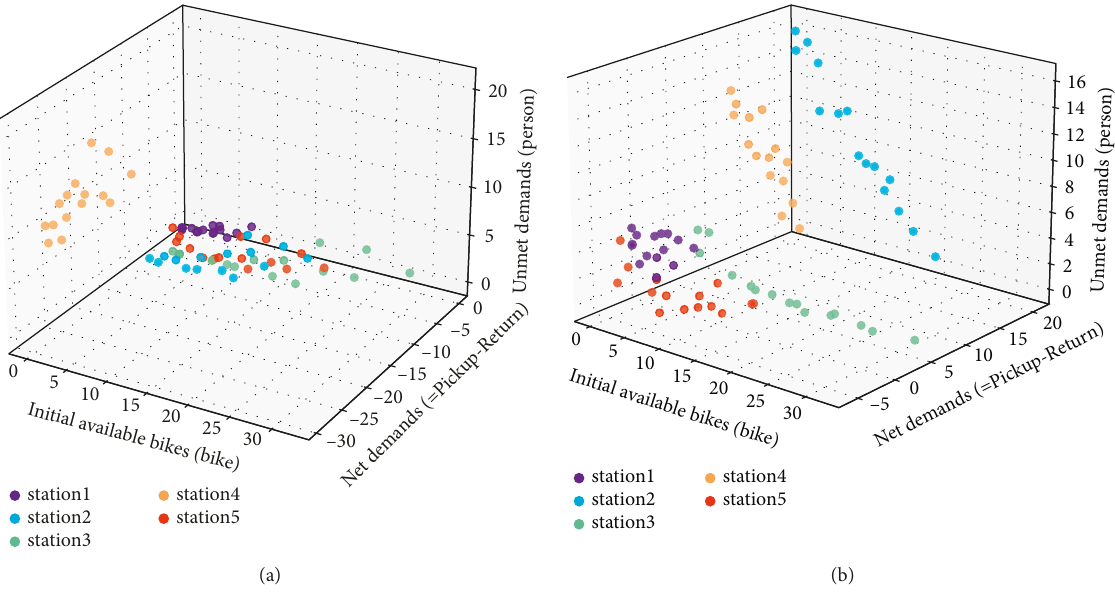
Figure 6: Relationship among initial inventory level, net demands, and total unmet demands. (a) Morning peak; (b) evening